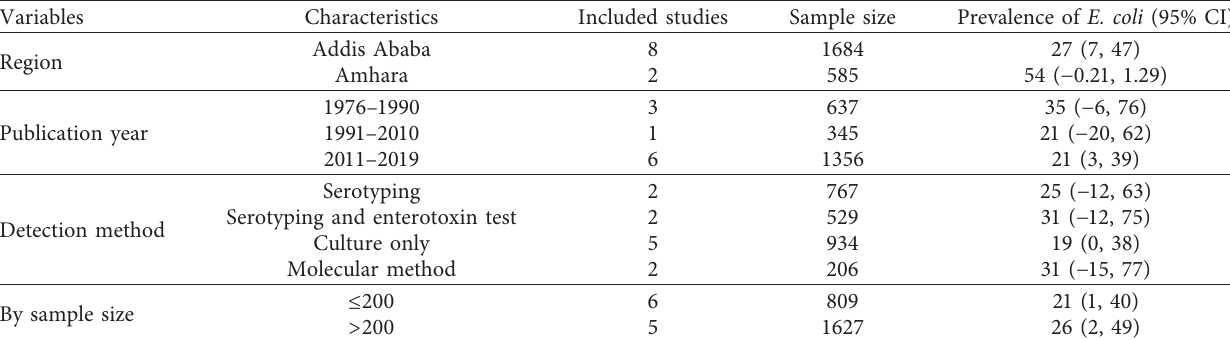
Table 2: Subgroup estimate of the pooled prevalence of Escherichia coli in under-five children with diarrhea in Ethiopia.